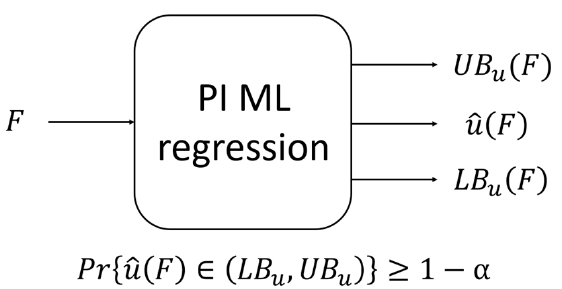
Figure 4. Prediction interval ML regression for estimate 𝐿𝐵 (cid:3048) —Spoiling knowledge lower bound for ECRE2.